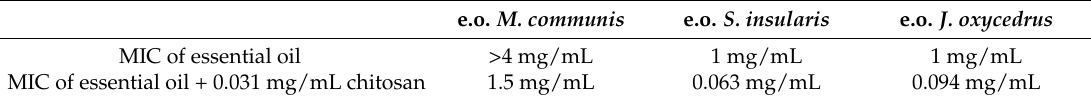
Table 1. Minimum Inhibitory Concentration (M.I.C.) of Myrtus communis , Santolina insularis and Juniperus oxycedrus essential oils against Cutibacterium acnes in the presence of a sub-inhibitory concentration of chitosan (M.I.C. chitosan against C. acnes = 0.063 mg/mL) (mean of 3